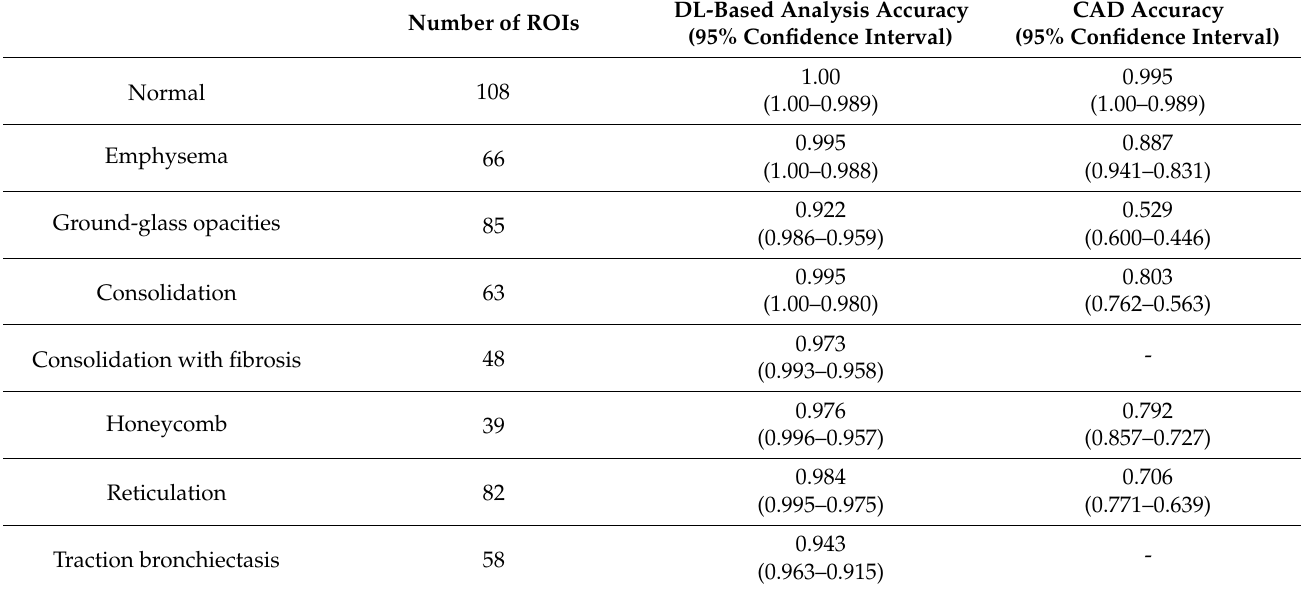
Table 4. DL-based analysis and CAD system output accuracy of each feature category.